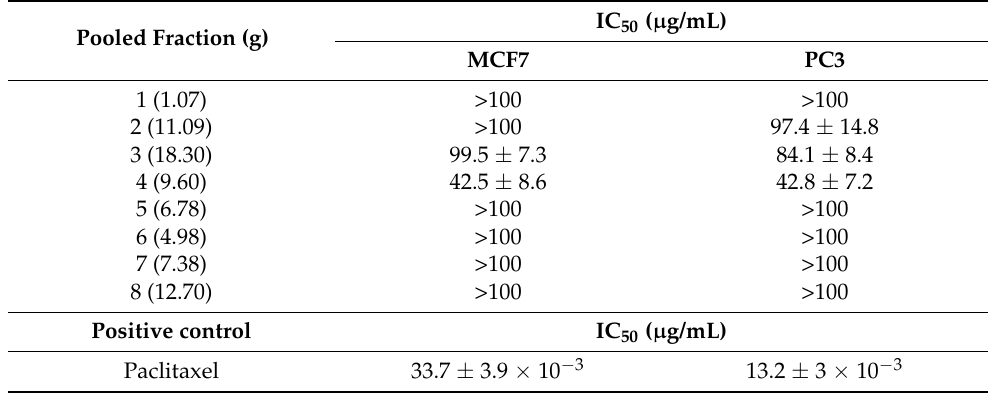
Table 2. Cytotoxic activity of pooled fractions of the CHCl 3 /MeOH extract. Pooled Fraction